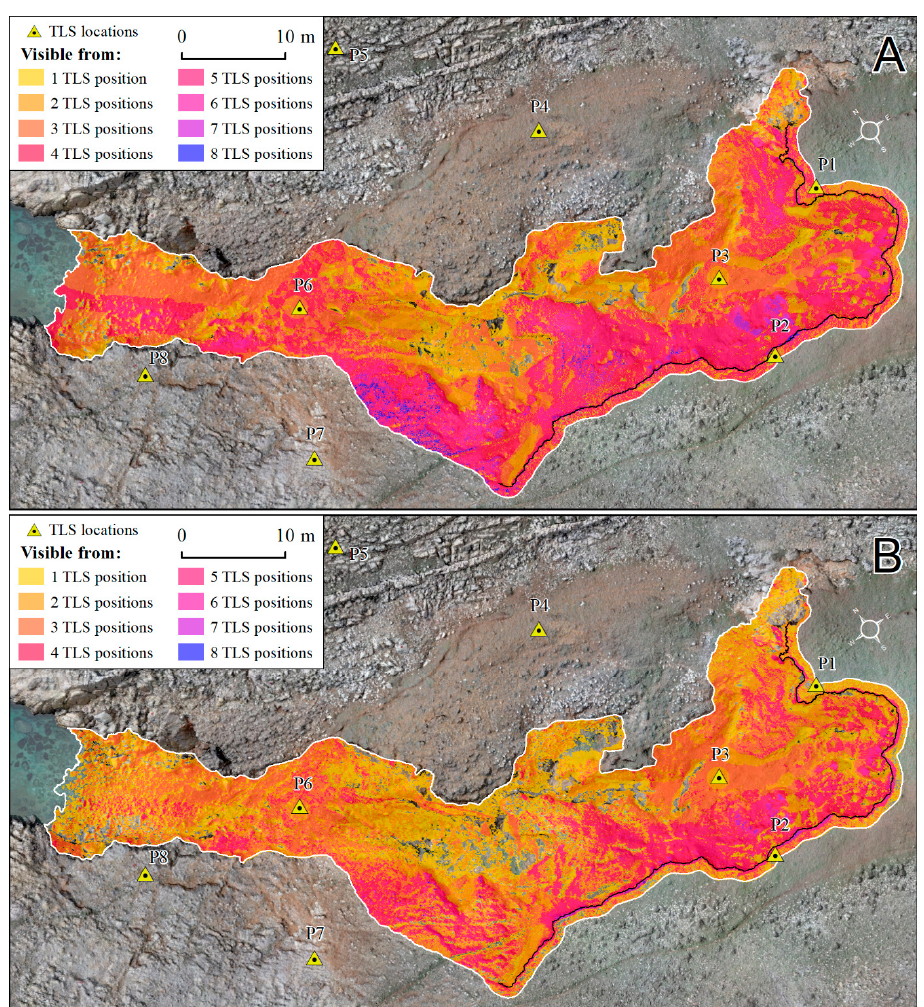
Figure 9. Difference between planned ( A ) and achieved ( B ) scan overlap for whole gully Santiš (SA-1). It should be noted that achieved coverage from individual TLS positions for SA-1 is slightly lower than the corresponding planned coverage (Table 2; Figure 10A). On aver- age, achieved coverage from each individual TLS position was lower by 4.93% than the planned coverage, while for some TLS positions, achieved coverage was even significantly lower (e.g., TLS position 7—10.34% (Figure 10A)). The highest deviation was recorded at TLS positions that were either within very steep and complex terrain (P2; P8; P7), or that were considerably distanced from SA-1 (P5) (Figure 9A). The smallest deviation (0.27%) of achieved coverage from planned was recorded in the third TLS position (P3), located